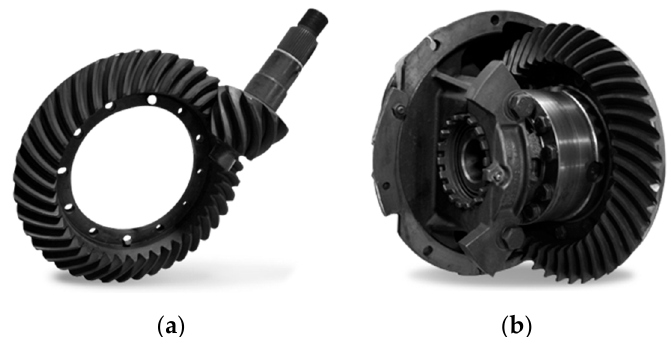
Figure 1. ( a ) Pinion and ring gears, ( b ) carrier differential.